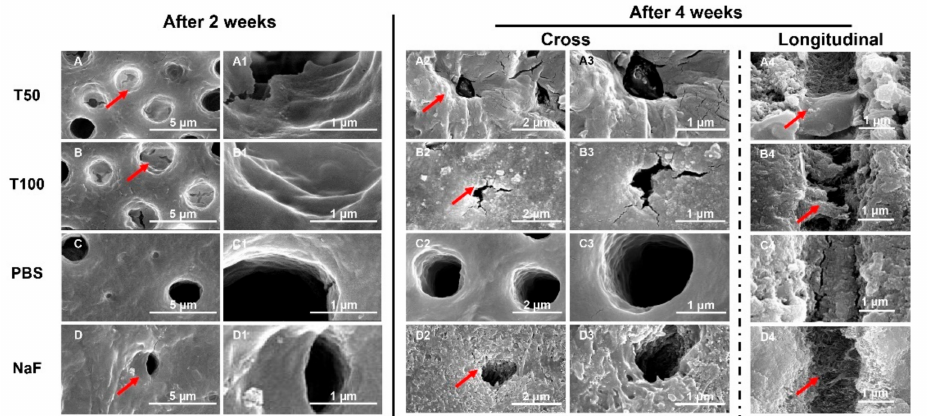
Figure 3. SEM images of the acid-etched tooth dentin surfaces ( A ) treated with 50 µ g/mL TVH-19, ( B ) 100 µ g/mL TVH-19, ( C ) treated with PBS and ( D ) 1000 ppm NaF, after being soaked in artificial saliva for 2 weeks ( A – D , A1 – D1 ) and 4 weeks ( A2 – D2 , A3 – C3 ) respectively. SEM images of longitudinal section of dentin tubules treated with ( A4 ) PBS, ( B4 ) 50 µ g/mL TVH-19, ( C4 ) 100 µ g/mL TVH-19 and ( D4 ) 1000 ppm NaF, after mineralization in artificial saliva for 4 weeks. The area indicated by the arrow is the remineralized